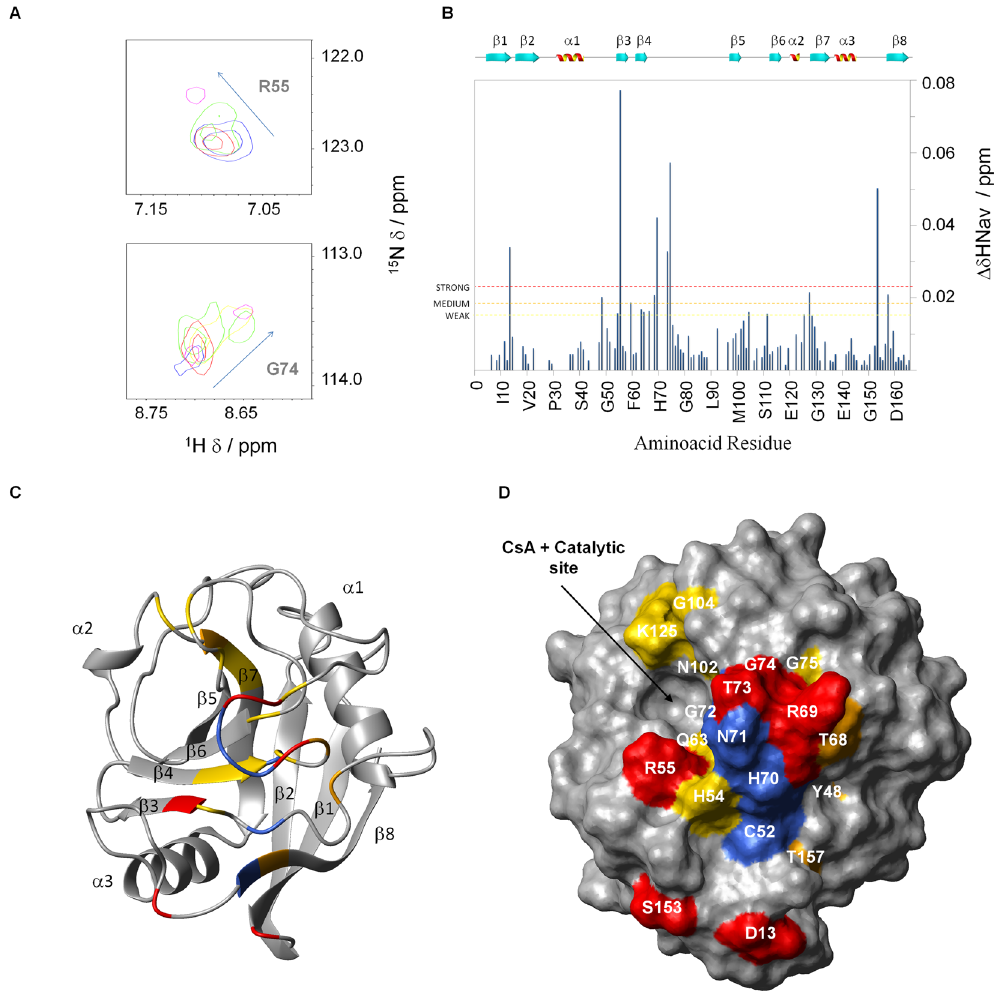
Figure 2. Identification of the AIF(370-394) interaction surface on CypA by NMR-CSP studies. ( A ) Superposition of two 2D [ 1 H, 15 N] HSQC section of 15 N-CypA in the absence (blue) and in the presence of different equivalents of AIF(370-394), 1 (red), 2 (green), 5 (yellow) and 10 (magenta), respectively. ( B ) Bar graphs of the average combined chemical shift difference ( Δ HN av ) as a function of the amino acid residue. Mean plus 2 SD, 1 SD and 0.5 SD Δ HN av values are indicated by red, orange and yellow broken lines, respectively. The secondary structure elements are also shown. ( C , D ) CSP data were mapped onto a ribbon drawing and solvent accessible surface of the representative conformer of the CypA NMR structure (PDB ID 1OCA) 28 and showed with a color gradient from yellow (weak) to orange (medium) to red (strong). Residues having cross-peaks totally or scarcely visible in the HSQC (C52 of the loop α 1- β 3; G65, H70, N71, G72 of the loop β 4- β 5; G135 of the loop β 7- α 3) were excluded from the CSP analysis ( B ) and are painted in navy on the CypA structure. Pictures C and D were prepared using the software MOLMOL 42